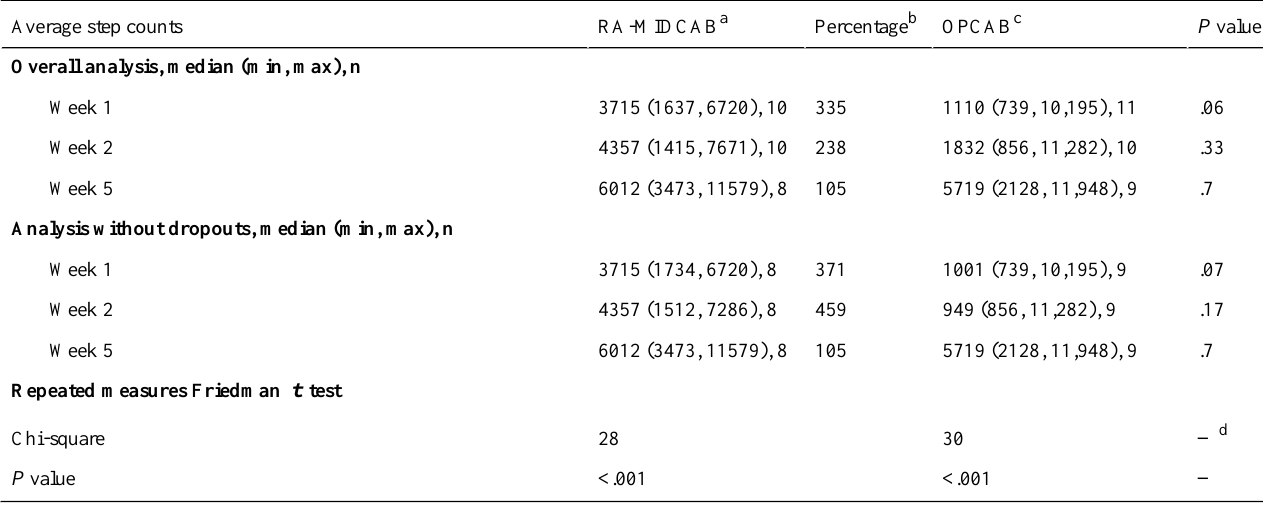
P valueOPCAB c Percentage b RA-MIDCAB a Average step counts